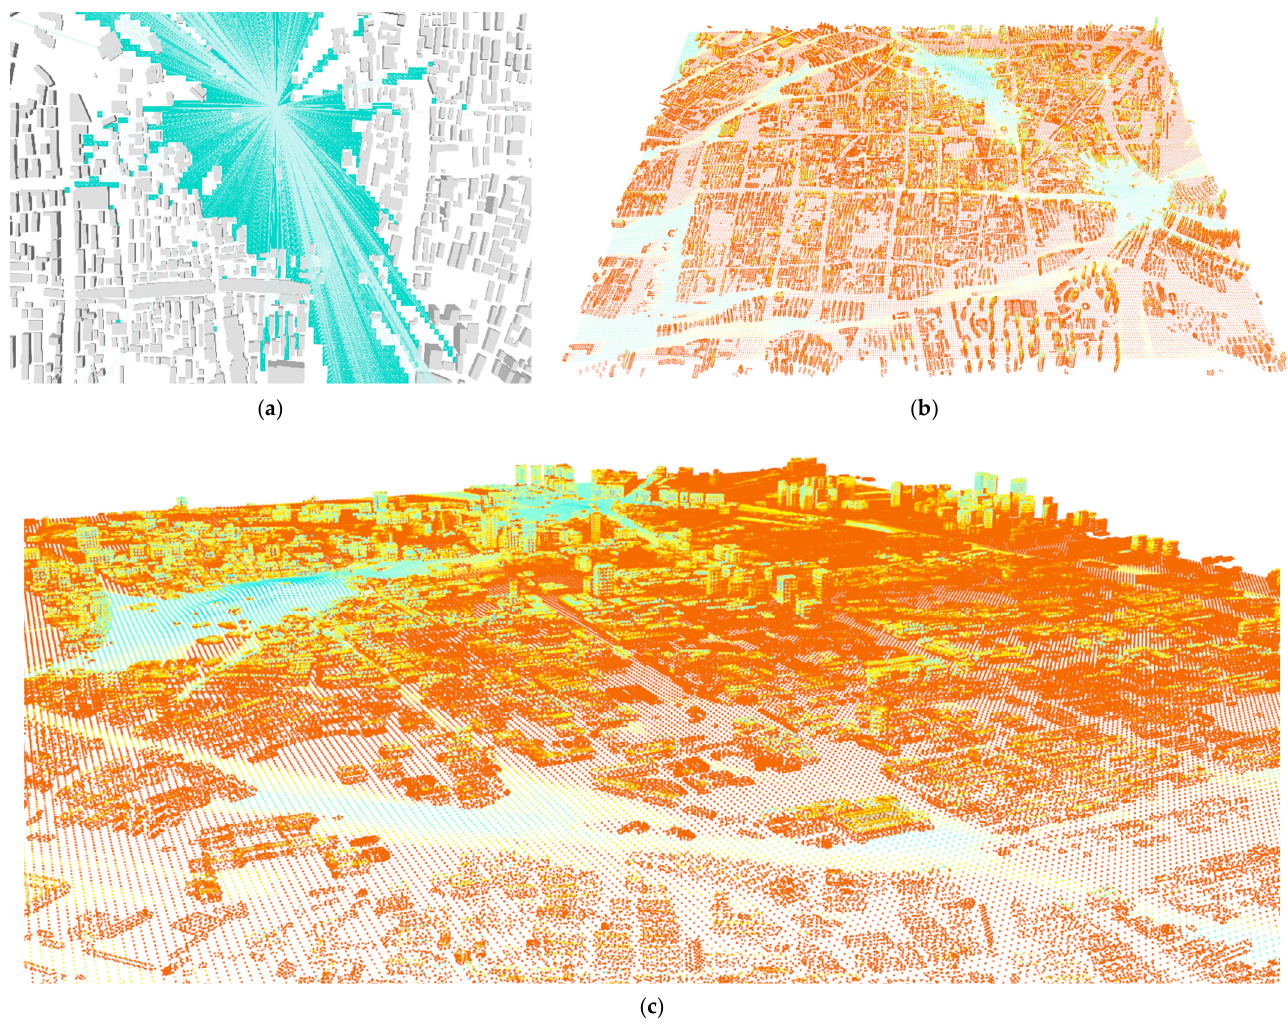
Figure 3. Multiple landscape attractions visibility: ( a ) demonstration of 3D ISOVIST by an optimized Ladybug view analysis; ( b ) data record by an ISO-matric-scan for multiple attractions; ( c ) data record by an ISO-matric-scan for multiple attractions, using a 20 by 20 m grid.